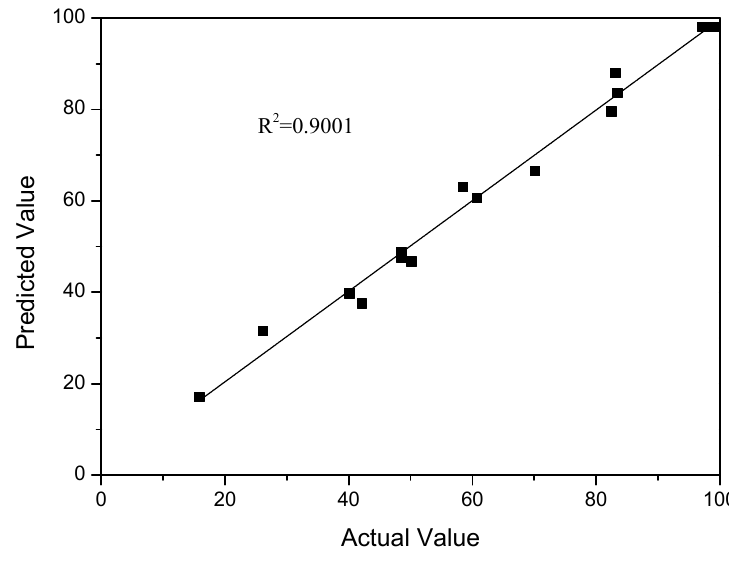
Figure 4. Predicted vs. actual 5 ‐ HMF yield.